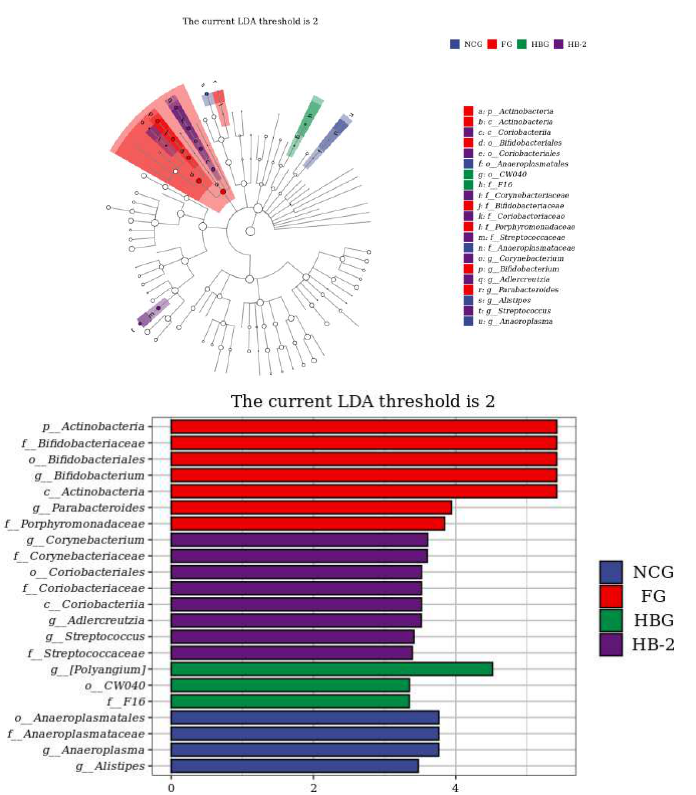
Figure 5. Effect of HB (Highland barley), HB-1 (microwave fluidized Highland barley), HB-2 (extruded and puffed Highland barley), and HB-3 (ultrafine pulverized Highland barley) on feces microbiota in HFCD mice, using linear discriminant analysis effect size (LEfSe) and linear discriminant analysis (LDA) statistical analysis methods. Feces microbial composition at the phylum level ( A ). Feces microbial composition at the genus level ( B ). Cladogram visualizing the output of the LEfSe analysis ( C ). The most significant difference of gut microbial taxa among groups after LDA ( D ).